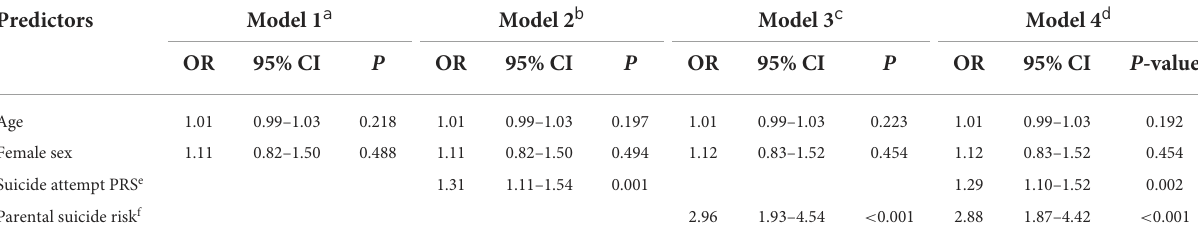
TABLE 2 Association of suicide attempt PRS, parental history of suicide attempt/death and suicide attempt in the meta-analyzed study population ( N =